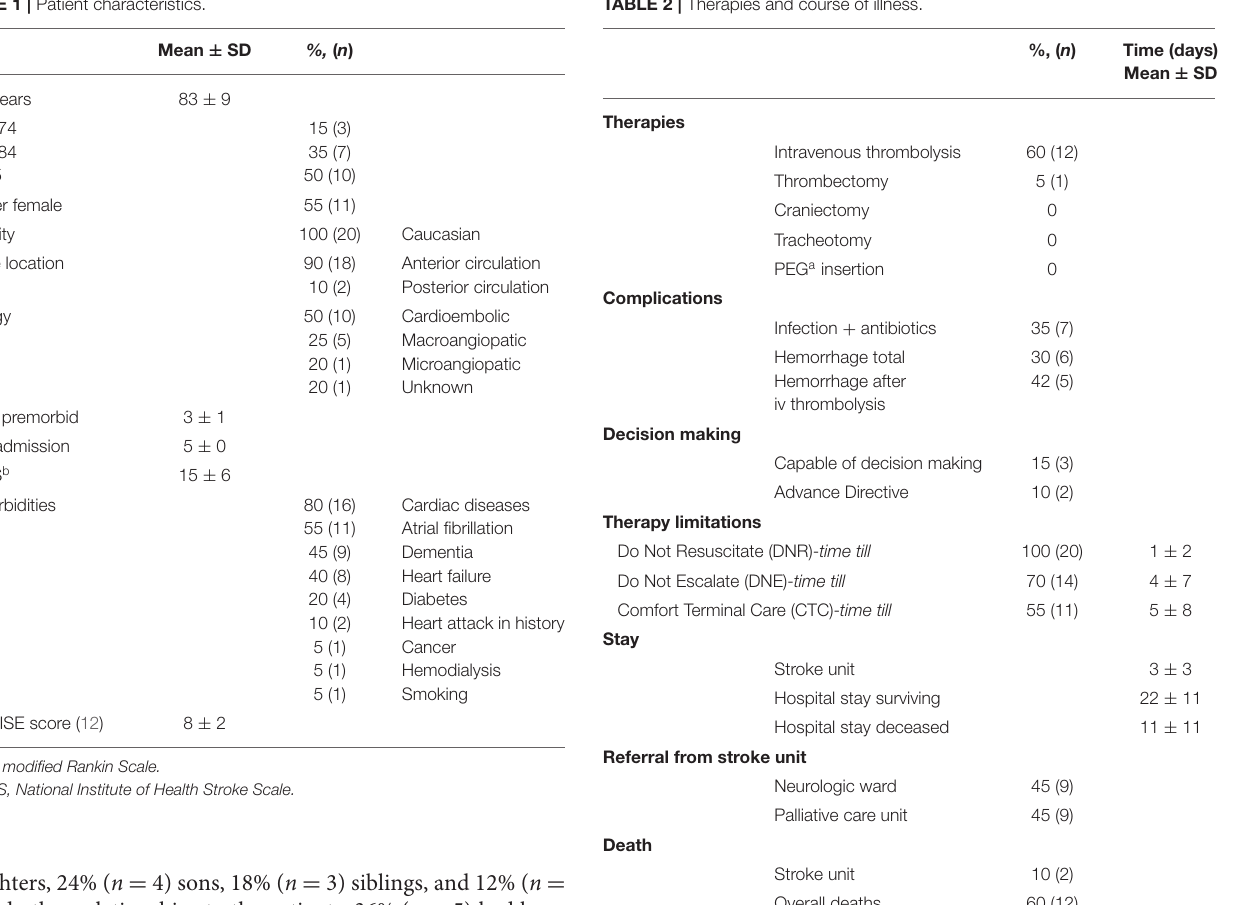
TABLE 1 | Patient characteristics. TABLE 2 | Therapies and course of